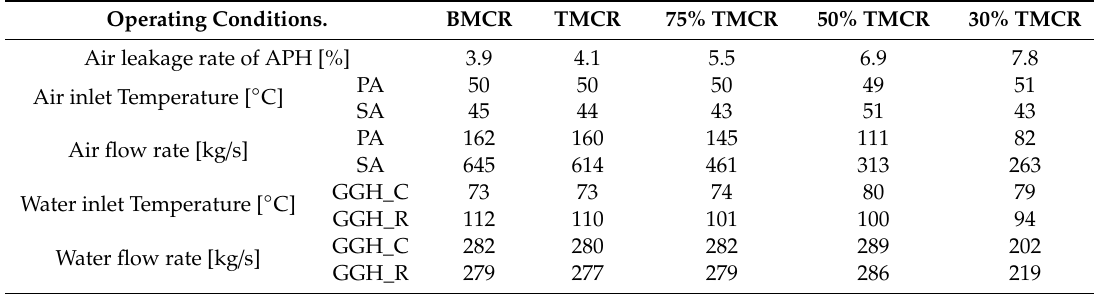
Table A2. Input conditions for the APH and GGH based on the five load conditions in the existing